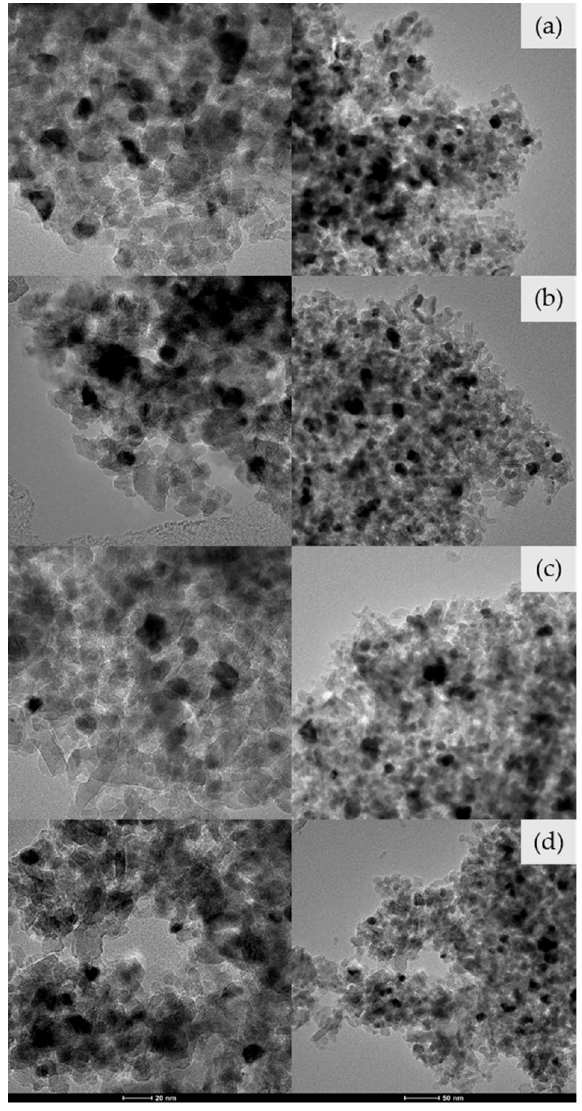
Figure 5. Transmission electron microscopy (TEM) images of ( a ) reduced PtSn-C, ( b ) reduced PtSn-B, ( c ) reduced PtSn-B-HCl5, and ( d ) reduced PtSn-B-HCl35.